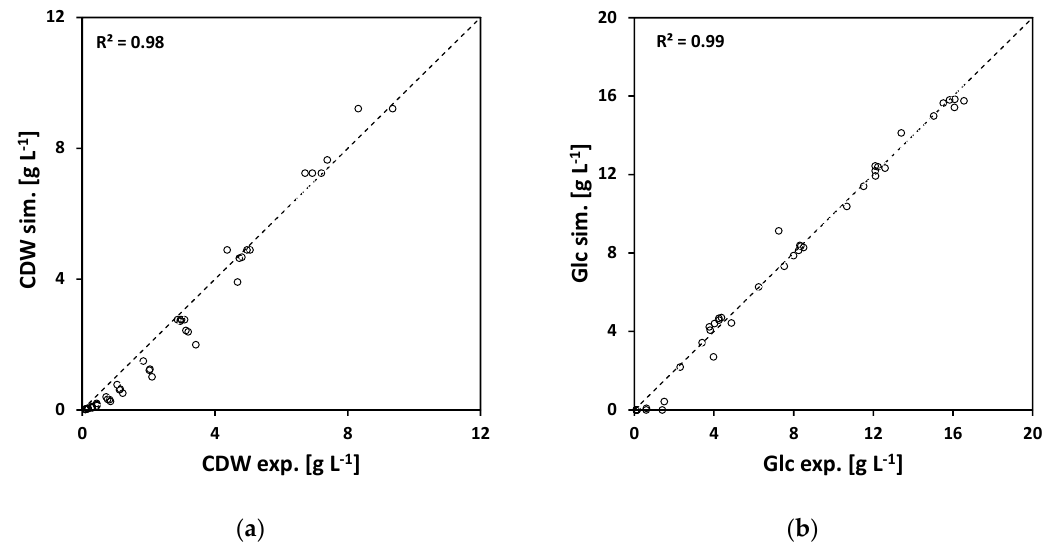
Figure 5. Quality of fit (Model A) for the shaking flask experiments with varying initial glucose levels of 5, 8, 12, and 16 g L − 1 for cell dry weight ( a ) and glucose ( b ) (conversion OD 600 1 ~ 0.39 g L − 1 ).